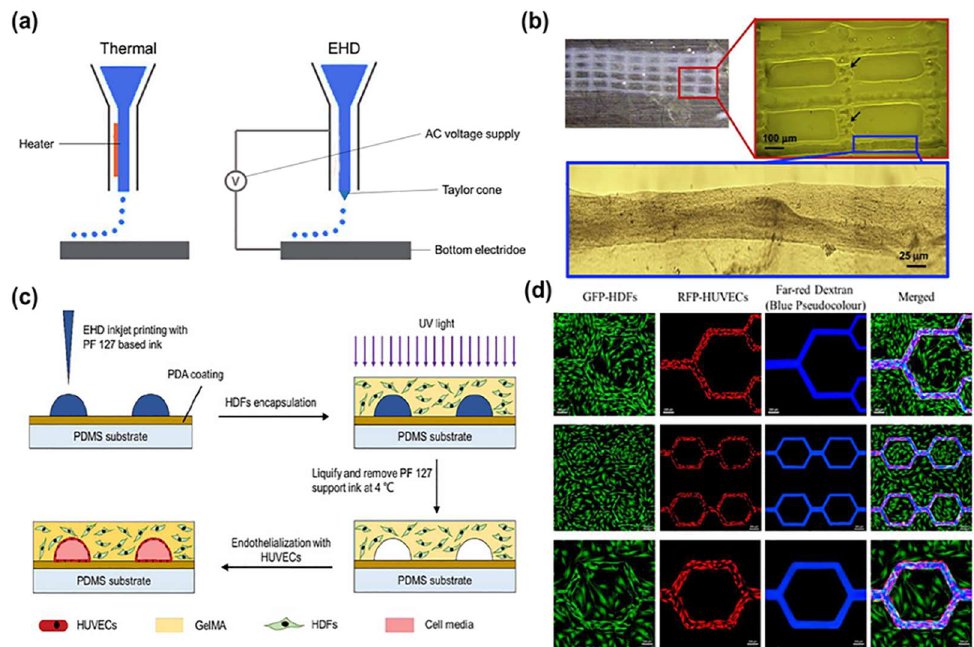
Figure 3. ( a ) Schematic diagrams of the thermal inkjet printing and EHD inkjet printing techniques. ( b ) Schematic of the manufacturing process using a sacrificial Pluronic F127 solution to form the microvasculature followed by casting a cell-containing methacrylated gelatin (GelMA) suspension and photopolymerization. Adapted from Ref. [21]. ( c ) Printed fibrin scaffold using modified thermal inkjet printer. Only minor deformations of the printed pattern were noticed at y-axis. ( d ) Perfusion of fluorescent dextran solution into a GFP-HDFs/RFP-HUVECs co-culture construct. Far-red dextran flow is marked as blue pseudocolour after image processing, reported by Zheng et al. ( c ) and ( d ) adapted from Ref. [26].